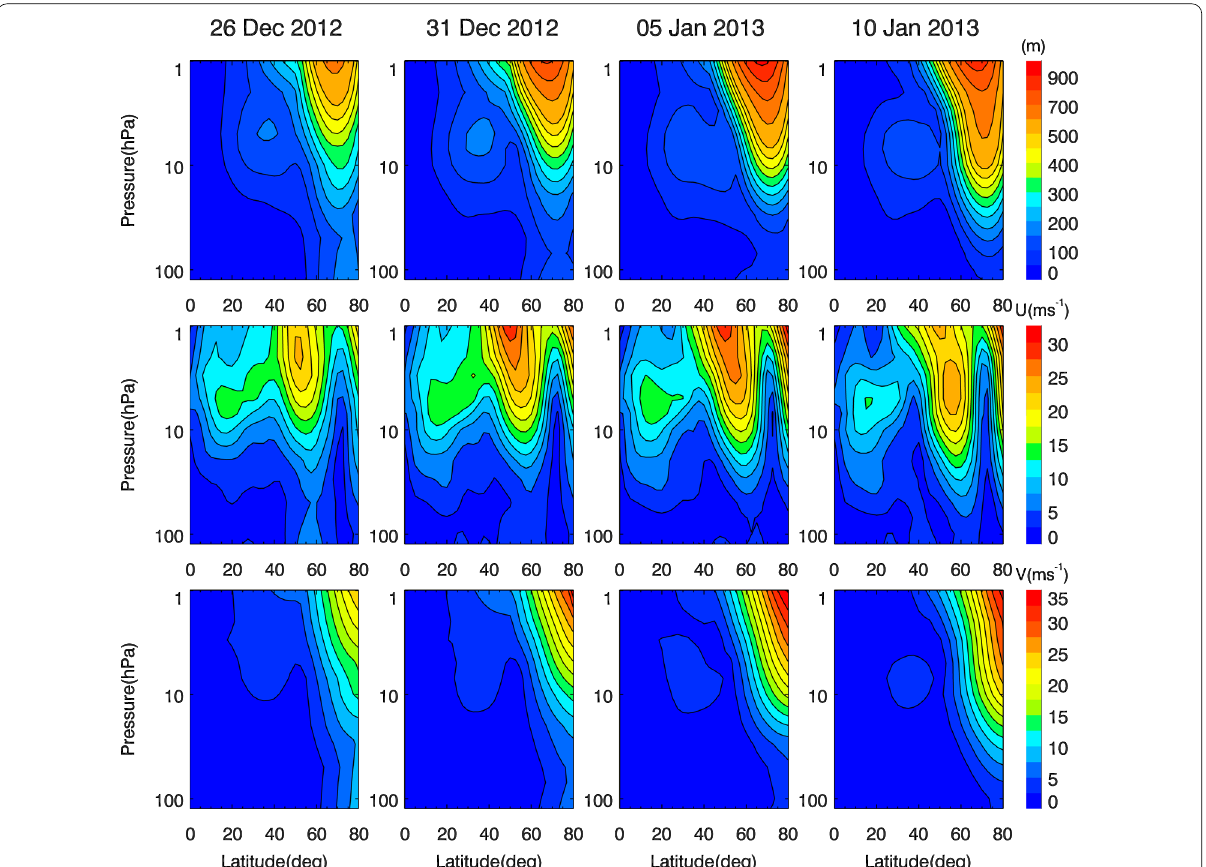
Fig. 13 Altitude versus latitude structures of the geopotential, zonal wind and meridional wind amplitudes of the W1 Q16DW (from top to bottom) in the NH on the same days as those shown in Fig.